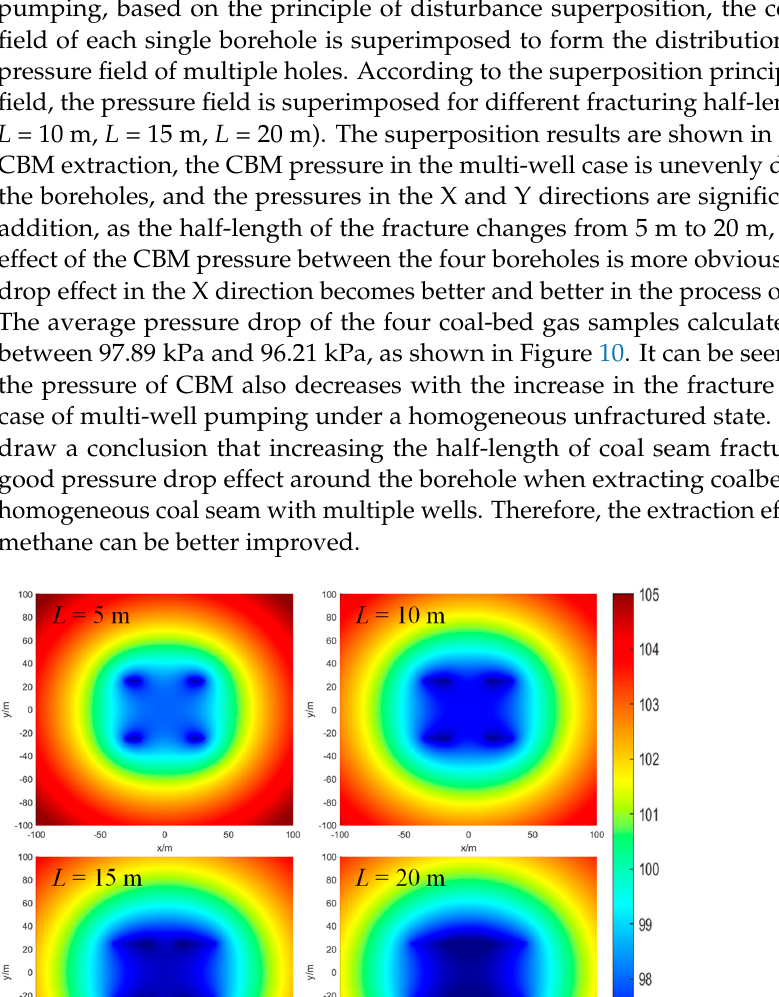
Figure 11. Pressure drop law of coal seam in multi-well fracturing reservoir. 3.5. Impact of Anisotropy under the Condition of Multi-Well Production without Fracturing Similar to the study under the condition of multi-well fracturing homogenization, the influence of the change in the anisotropy coefficient on the coal seam pressure drop is compared under the condition of multi-well fracturing, and the results are shown in Fig- ure 12. The anisotropy coefficients are equal to 2, 4, 6, and 8. It can be observed from Figure 12 that the CBM pressure in the X direction of the superimposed CBM pressure field is significantly smaller than that in the Y direction. With the change in anisotropy coefficient from 2 to 8, the uneven distribution of pressure in the X and Y directions is more obvious, the pressure drop range in the X direction is larger, and the pressure drop range in the Y direction is smaller. We can conclude that when extracting coalbed methane without frac- turing in multiple wells, the existence of coal seam heterogeneity can affect the pressure drop around the borehole, and with the increase in coal seam heterogeneity, the pressure drop effect around the borehole becomes better and better. Therefore, the extraction effi- ciency of coalbed methane can be better improved.